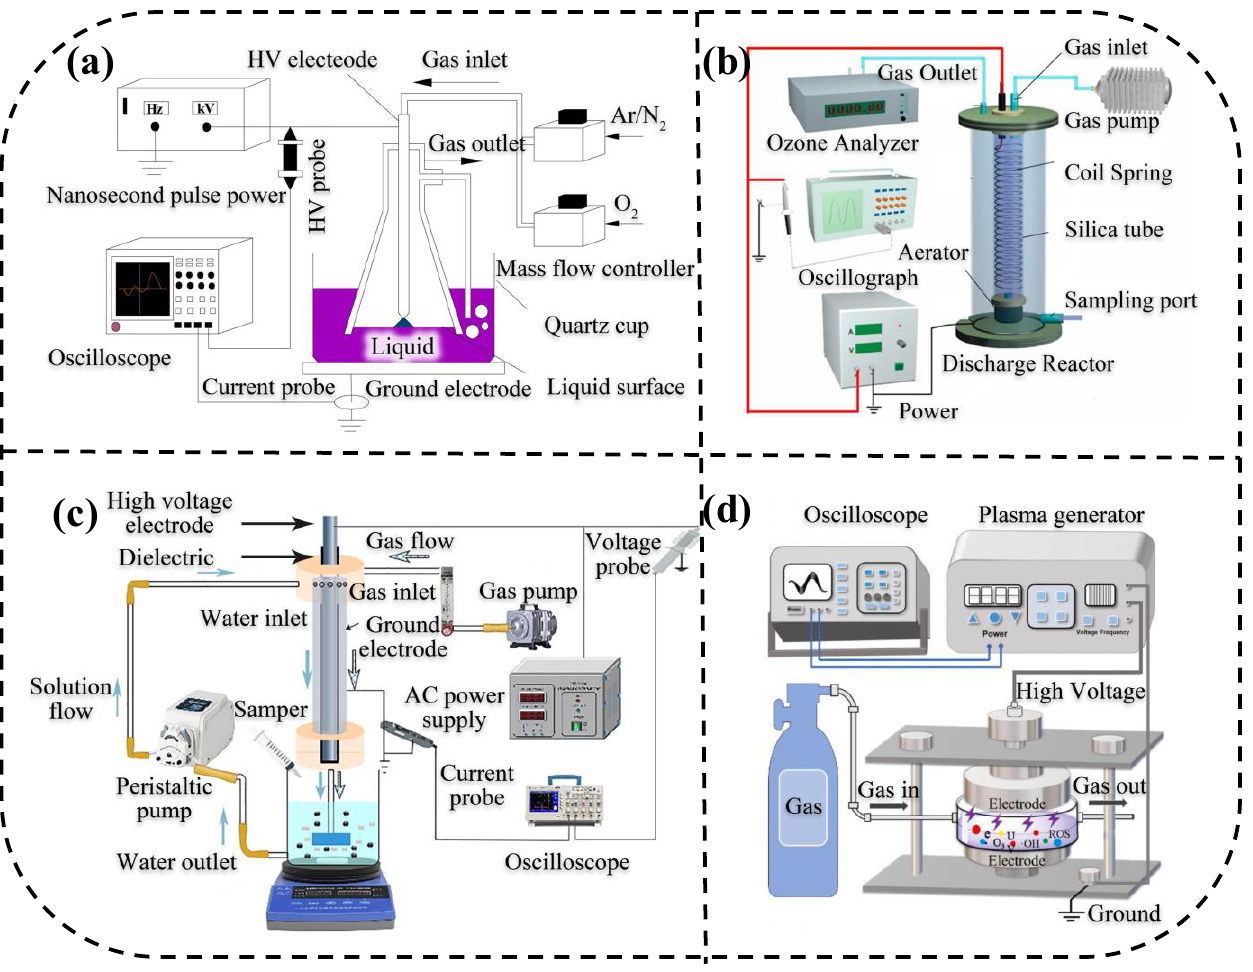
Figure 2. Structure chart of various DBD reactors: ( a ) Structure chart of jet DBD system reactor [32]; ( b ) Structure chart of coaxial DBD system reactor [33]; ( c ) Structure chart of falling-film DBD system reactor [33]; ( d ) Structure chart of plate – plate DBD system reactor [35].